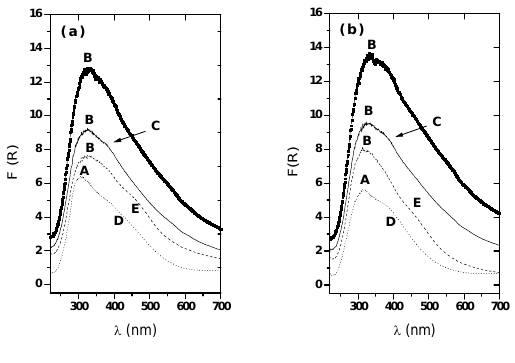
Fig. 2 – DRS spectra after successive treatment cycles; – ( · · ·· ) oxidation, ( ) reduction, ( — ) reduction +3% H 2 O/He at 673K, ( - - - - ) reduction +3% H 2 O/5% O 2 /He at 673K. (a) Pd-Cl e (b) Pd-acac.